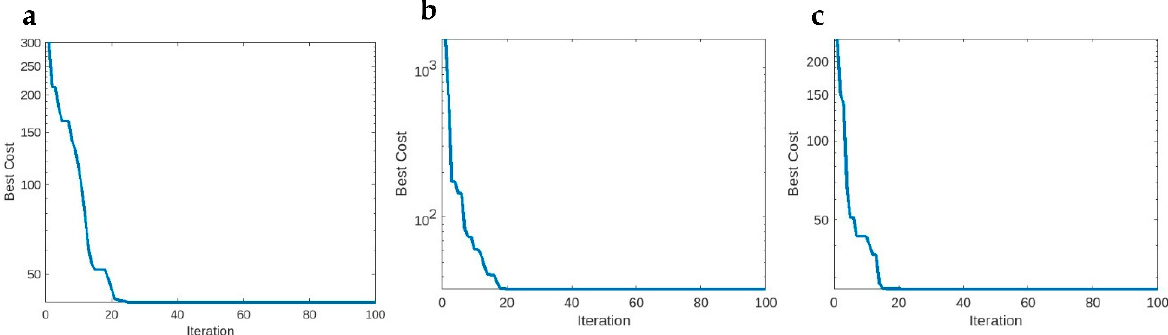
Figure 2. Best cost of in vitro gas production for legume forages ( a ) alfalfa, ( b ) vetch, and ( c ) clover.